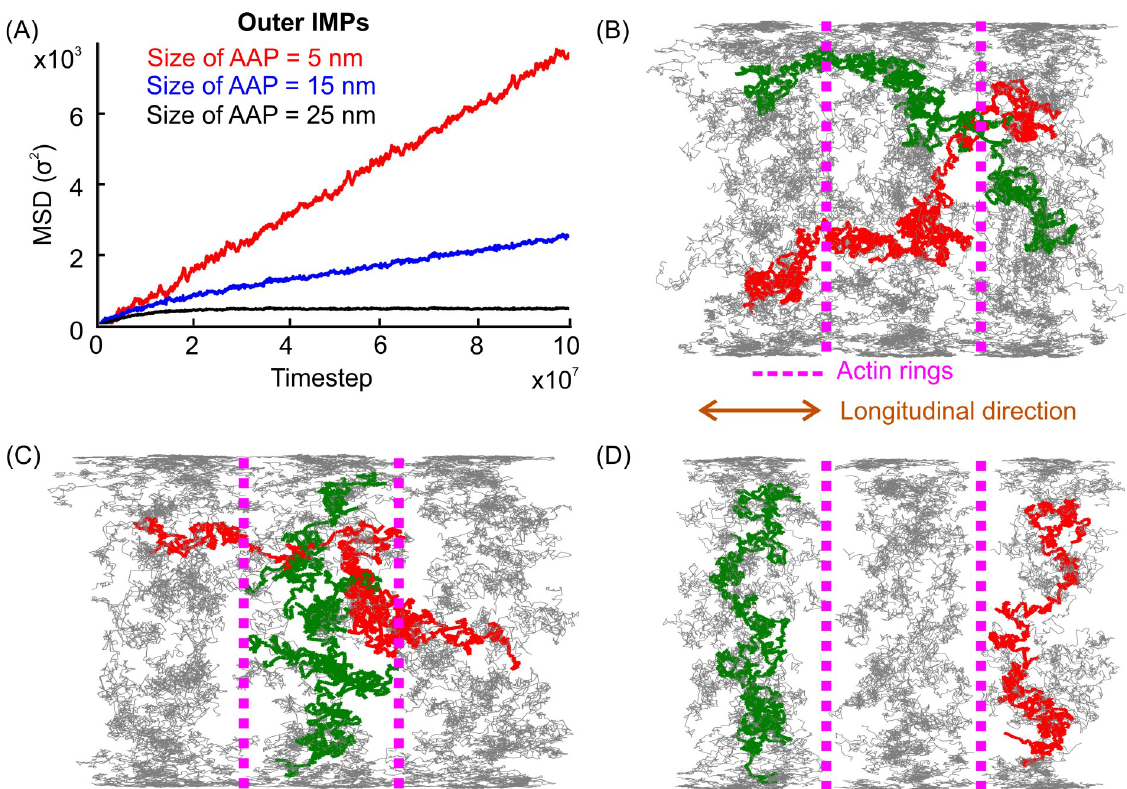
Fig 4. MSDs and trajectories of the outer leaflet IMPs with actin-anchored proteins (AAPs) of different sizes. (A). Longitudinal MSDs of IMPs in the outer leaflet with three sizes of AAPs. Panels (B), (C), and (D) show the trajectories of 5 nm, 15 nm, and 25 nm AAPs,